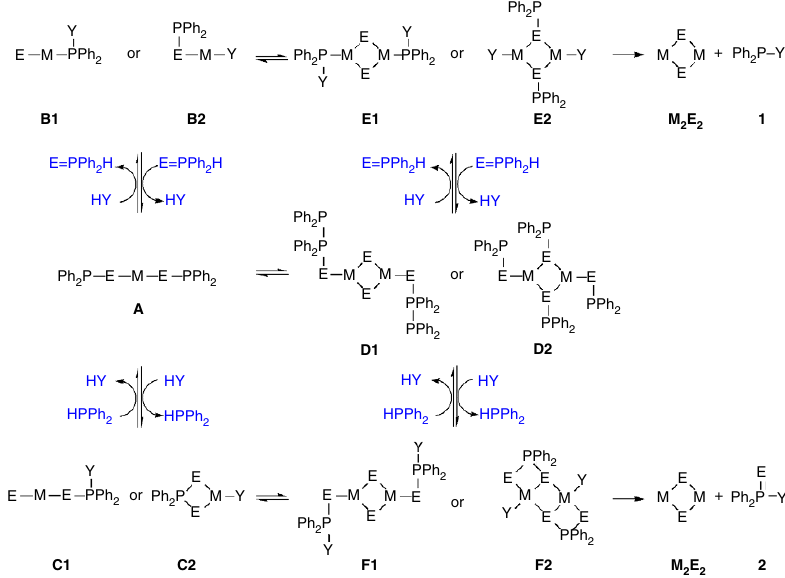
Figure 7 | Possible isomers with binding skeletons. Here two of the most probable constitutional isomers of intermediates B to F are shown; there are 99 CdSe-containing isomer structures computed as shown Supplementary Tables 4–17. With M ¼ Cd and E ¼ Se, B1 and C1 are favoured for Y ¼ NHR, whereas B2 and C2 are preferred for Y ¼ SR, OOCR. For Y ¼ OR, the distinction is not clear cut. For the immediate precursors E and F leading to monomers Cd 2 Se 2 with Compounds 1 and 2 , respectively, E1 and F1 are favoured for Y ¼ NHR and OR, whereas E2 and F2 are preferred for Y ¼ SR and OOCR. For Y ¼ PPh 2 , D2 is more stable than D1 . Possibly, the release of Compound 1 is more apparent from E1 (via the M –P bond cleavage) than from E2 , while Compound 2 from F1 (via the M – E bond cleavage) than from F2